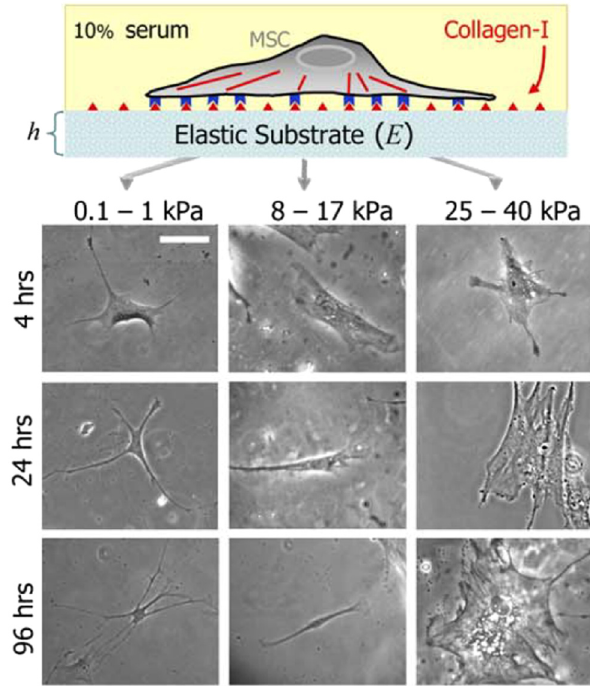
Figure 3: Cell adhesion and morphology were controlled by col - lagen - I and sti ff ness of substrate ( reproduced from ref. [ 36 ])